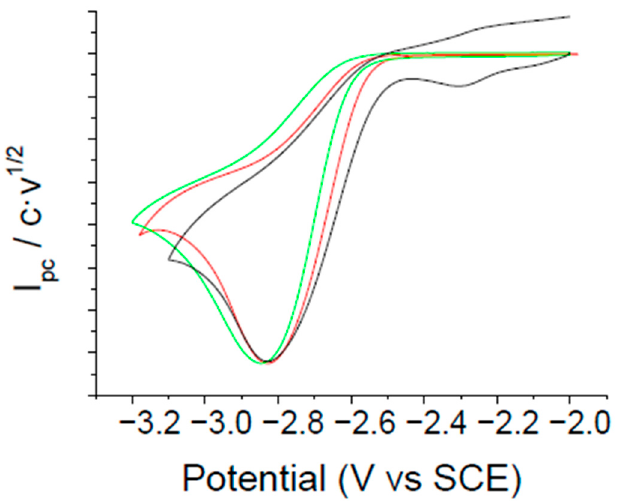
Scheme 4. Proposed mechanism for the electrochemical reduction of α , α , α -trifluorotoluene.